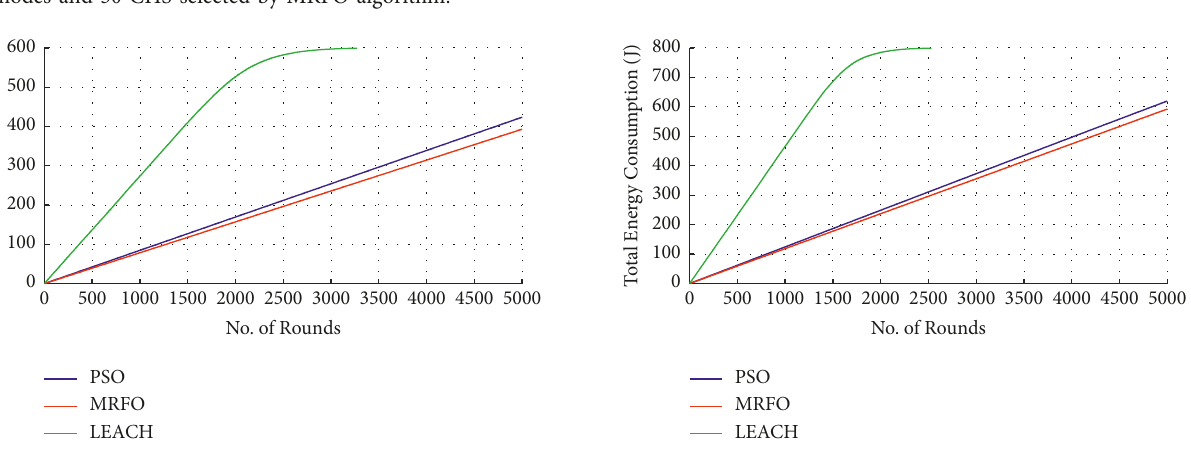
Figure 9: Total energy consumption for 300-node network, 30 CHs when the BS is at the center of